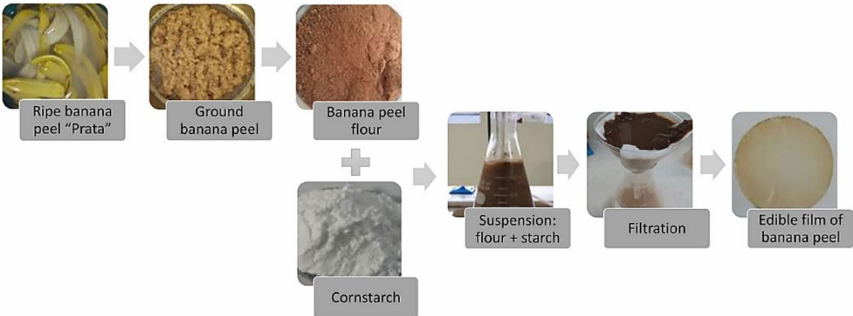
Figure 7. Development of edible coatings from banana peel. Reproduced with permission from Ref. [100]. Copyright 2021